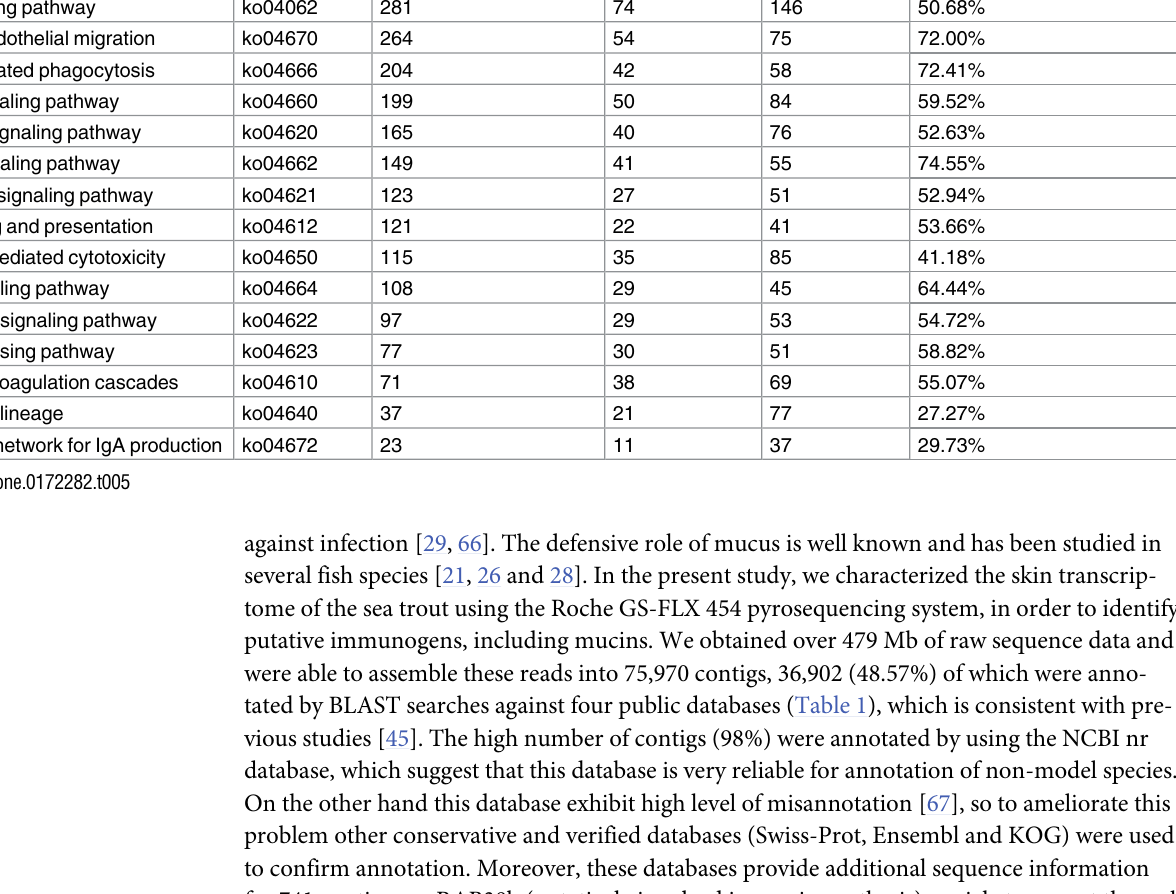
Table 5. List of the immune pathways identified in the sea trout skin transcriptome. Pathway name KO identifier Associated sequences Mapped genes Known genes Identified/known genes